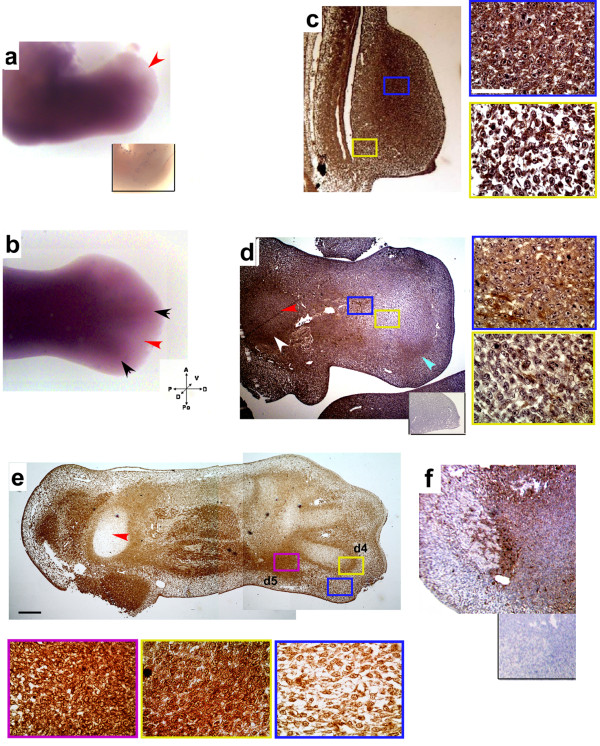
CG-1A is localized to developing chicken leg bud precartilage condensations. (a) Staining by in situ hybridization for CG-1A mRNA in the core of a 5-day leg bud with the distal-most cells underlying the AER unstained (red arrowhead). Inset shows control 5-day leg bud with probe omitted. In a 6-day leg (b), digits stain for CG-1A mRNA (black arrowheads) but interdigits are unstained (red arrowhead) (c) Indirect immunostaining for CG-1A protein in the 3½-day leg bud stylopod is predominantly extracellular (high-magnification view of the field enclosed by the blue box). Flank cells are sparsely stained (yellow box). (Scale bar: 50 μm). (d) In a 5-day leg section there is staining for CG-1A in the stylopod perichondrium (white arrowhead) but not its core (red arrowhead). In the zeugopod, the two intensely stained primordia (blue box) are separated by a region of unstained cells (yellow box). The developing autopodium is unstained except for a crescent representing the fourth digit condensation (blue arrowhead). Inset shows leg section with primary antibody omitted. (e) The peristylopod mesenchyme in a 6-day leg section stains for CG-1A, but not the core (red arrowhead). Fusiform cells in the intensely stained mid-leg were confirmed in companion sections to be myoblasts. Strong CG-1A staining is seen in the perichondria and leading edges of the third and fourth digits (yellow box), and in the ultimately regressing "fifth" digit condensation (violet box). Interdigit cells as well as those subjacent to the ectoderm stain sparsely (blue box). The fourth and fifth digits are marked as d4 and d5. (f) 5-day wing stylopod, showing intense CG-1A staining in the humeral crescent. Inset shows a comparable region (at lower magnification) of a control wing with primary antibody omitted. (Scale bar (e): 1 mm). Pull-out images were photographed using a 63× objective (Scale bar: 50 μm).